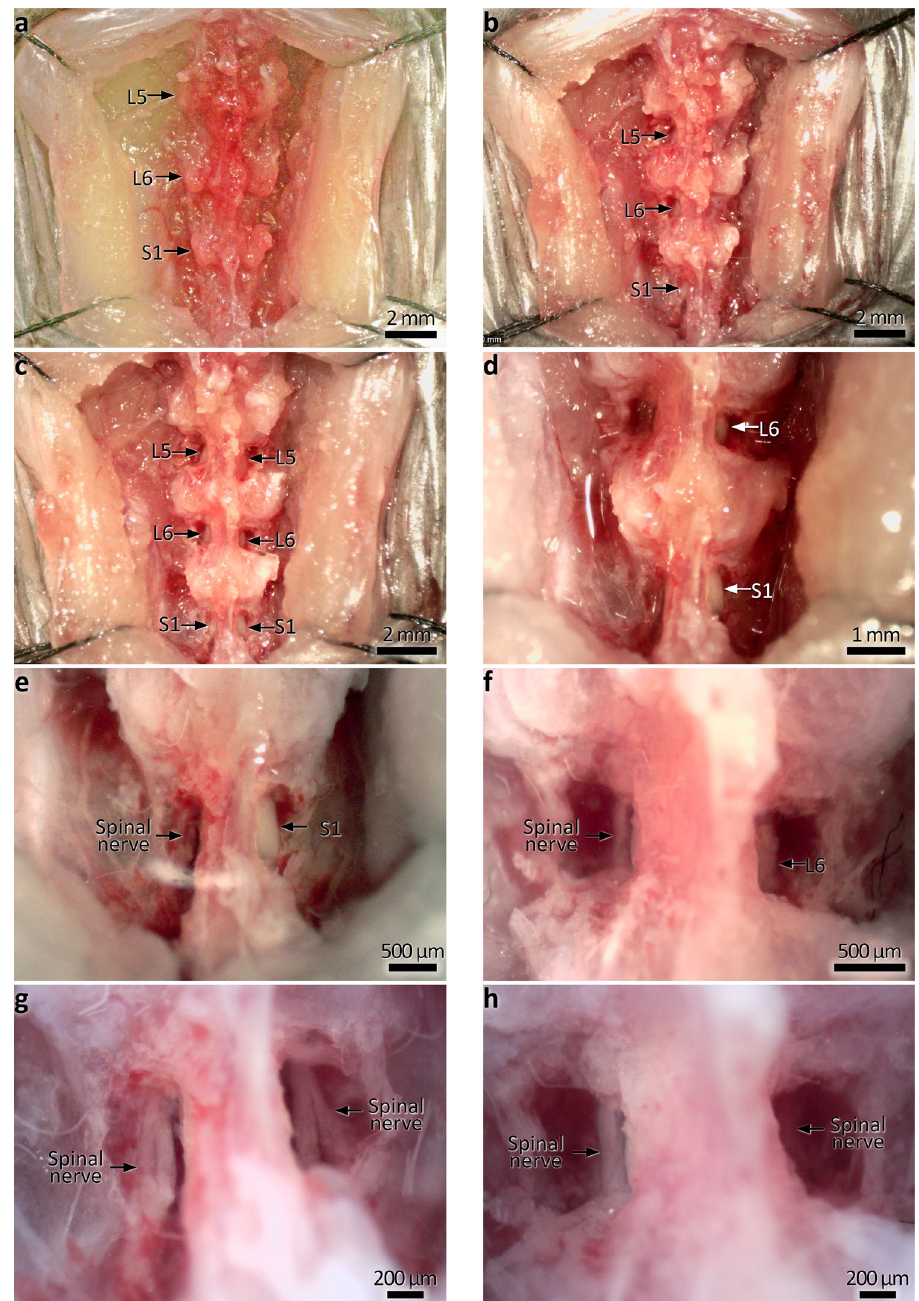
Fig. 2 Stages of bilateral lumbosacral DRG removal. a Midline section and retraction of the dorsal skin and musculature. DRG are not revealed, arrows indicate the vertebral levels; DRG lie at the junctions between vertebrae, approximately midway between the mammillary processes. b A single bank of DRG (L5-S1) are revealed by removing dorsal vertebral bone between the transverse processes. Arrows point to the exposed DRG. c Both banks of DRG exposed using the same method. Arrows point to the exposed DRG. d The DRG are carefully cut from the spinal nerves following exposure. This involves severing the dorsal root but not the ventral root (see Fig. 3a – d). In this higher magni fi cation photo, L6 and S1 are removed on the left side; arrows indicate remaining intact DRG on the right side. The L6 DRG lies approximately parallel to the iliac crest of the hip bones. e , f Higher magni fi cation photos of S1 and L6, respectively. Spinal nerves with DRG removed are indicated on the left side; intact DRG remain on the right side. g , h The same regions after bilateral DRG removal. An example of the section of the dorsal root prior to DRG removal ex vivo is shown in Fig. colorectum was selectively abolished in speci fi c areas of the spinal cord by removal of selective sets of DRG. These results further support the idea that pain signalling from the colorectum is mediated by both LS and TL spinal sensory neurons. Analysis of distension-evoked pERK expression in major dorsal horn sub- regions are shown in Fig. 8a – f.